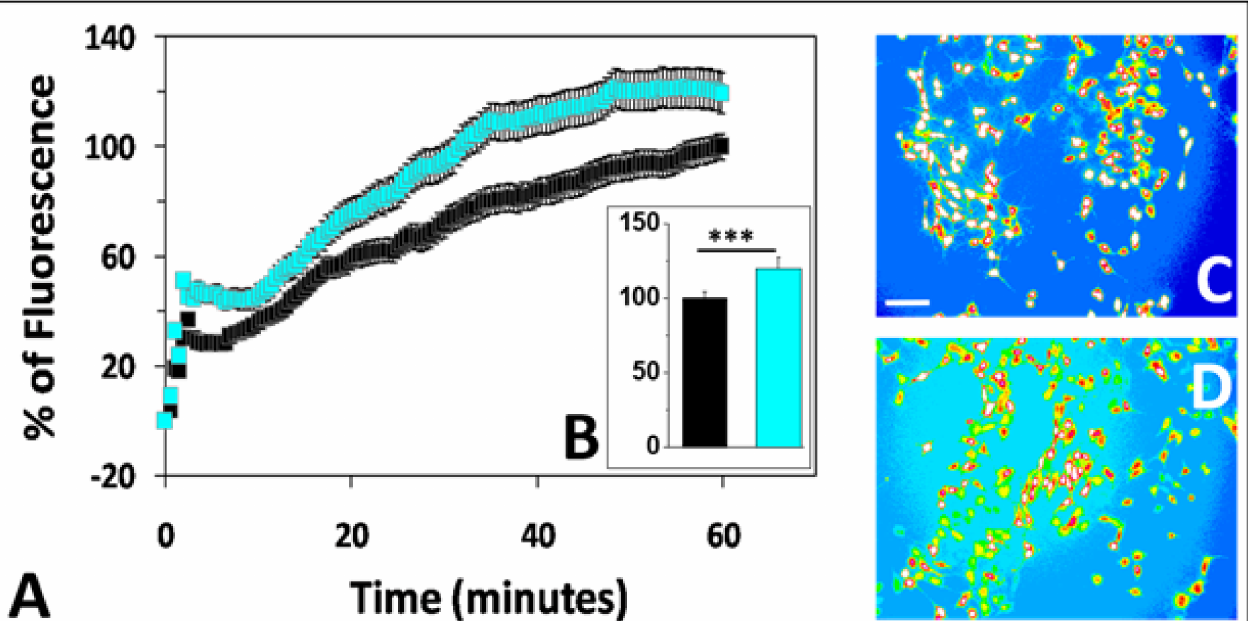
Figure 3. Ca 2+ entry into SH-SY5Y-AmyP53 cells treated with the calcium ionophore A23187.SH-SY5Y-AmyP53 cells were preloaded with Fluo-4AM, then incubated with A23187 at a concentration of 0.2 µ M (black symbols) or 2 µ M (cyan symbols). The data show the kinetics ( A ), histograms at 60 min ( B ) and Ca 2+ imaging ( C , D ) of ionophore-treated cells. The images in panels C and D show pseudocolor representations of cells after 60 min of incubation with A23187 at a concentration of 0.2 µ M and 2 µ M, respectively. The pictures are representative of three independent experiments, scale bar: 100 µ m. Results in the kinetics ( A ) and in the histogram ( B ) are expressed as mean ± SEM. Student’s t -test was used to compare the statistical significance. *** p < 0.0005 with 109 < n <